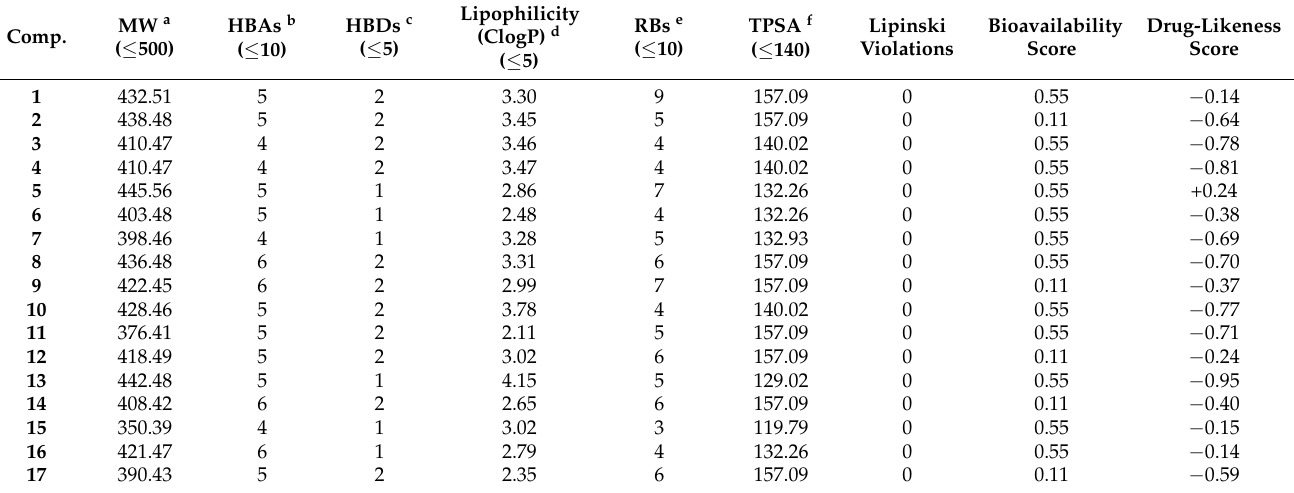
Table 6. Drug-likeness predictions of tested